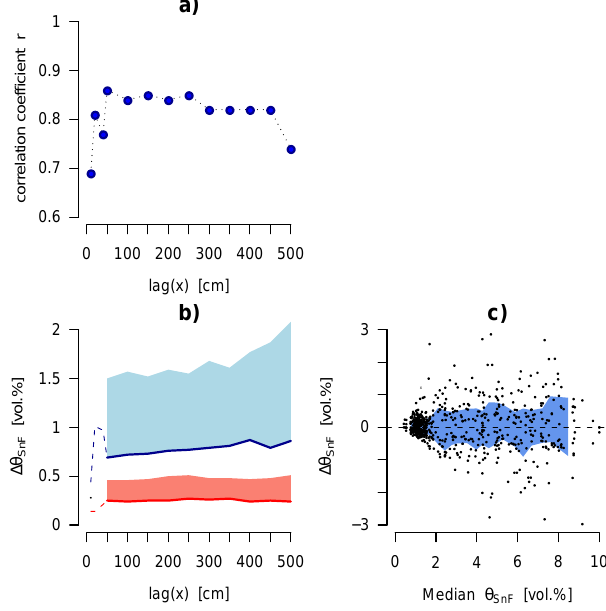
Fig. 9. Variability in measured water content as a function of lag- distance between measurements and water content. (a) Pearson cor- relation coefficient r for all measurement pairs with the same lag distance lag (x) . (b) Difference in liquid water content ( ∆ θ SnF ) be- tween measurement pairs at lag distance (x). Compared are the me- dian (bold line) and the range between median and the third quartile for each lag distance (shaded area). The data-set is split into mea- surements where the median θ of the measurements taken over 5m was less than 1.3vol.% (lower values, red) and more than 1.3vol.% (higher values, blue). (c) Difference between median water content and the first and third quartile (always measured within 5m dis- tance, ∆ θ SnF ). The shaded area highlights the interquartile- range averaged over 25 measurements.